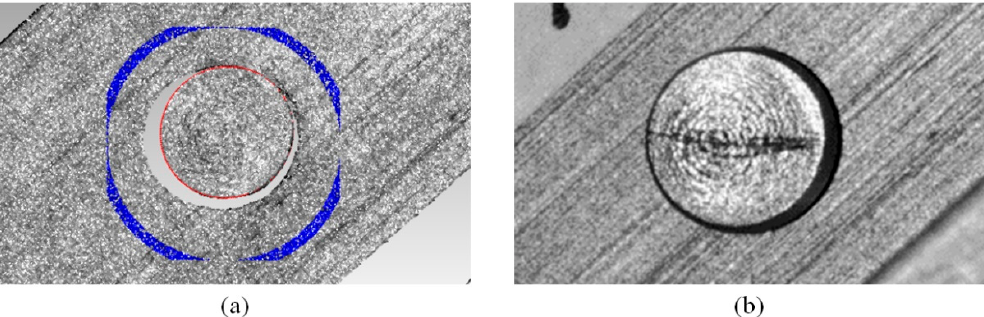
Figure 7. ( a ) Regional 3-D reconstruction of the riveted workpiece by using the proposed method. The red points are the edge compensated by texture constraint, while the blue region is the bottom surface for height extraction. ( b ) the HDR texture of a damaged rivet, where the damage is enhanced by HDR fusion.